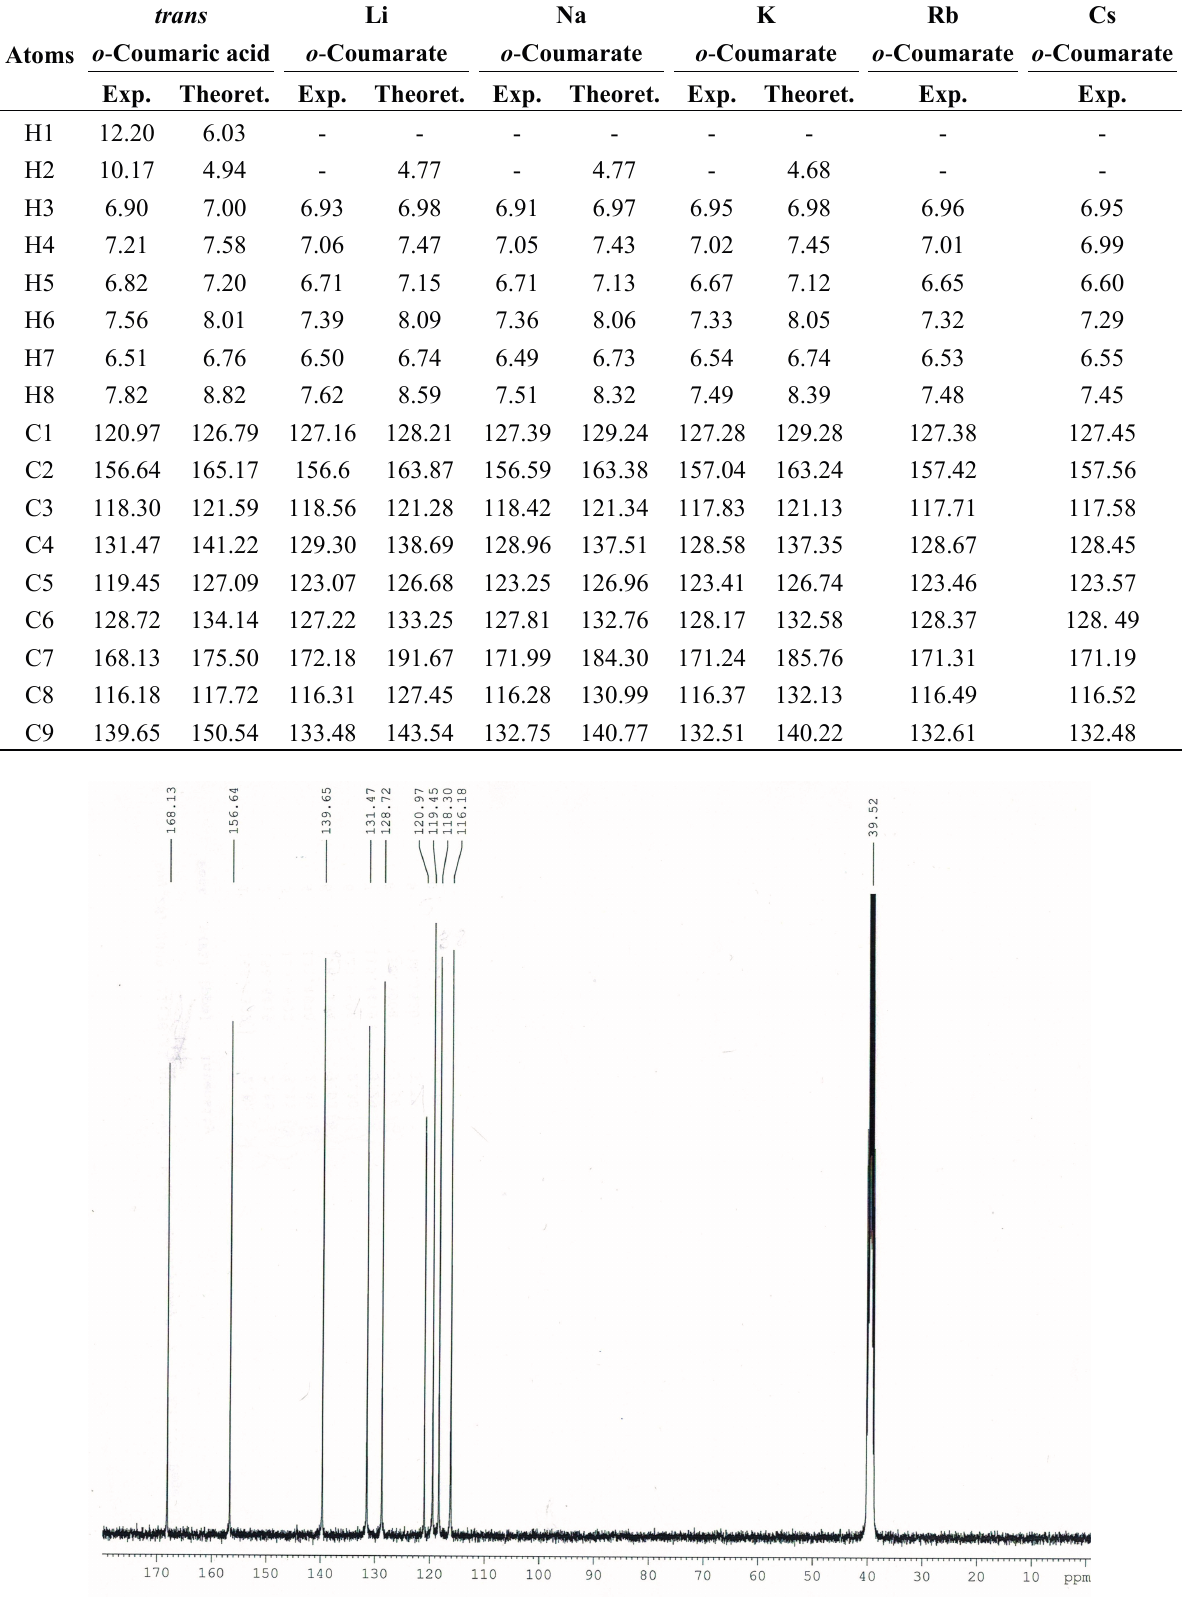
Figure 3. Experimental 13 C-NMR spectrum of trans o- coumaric